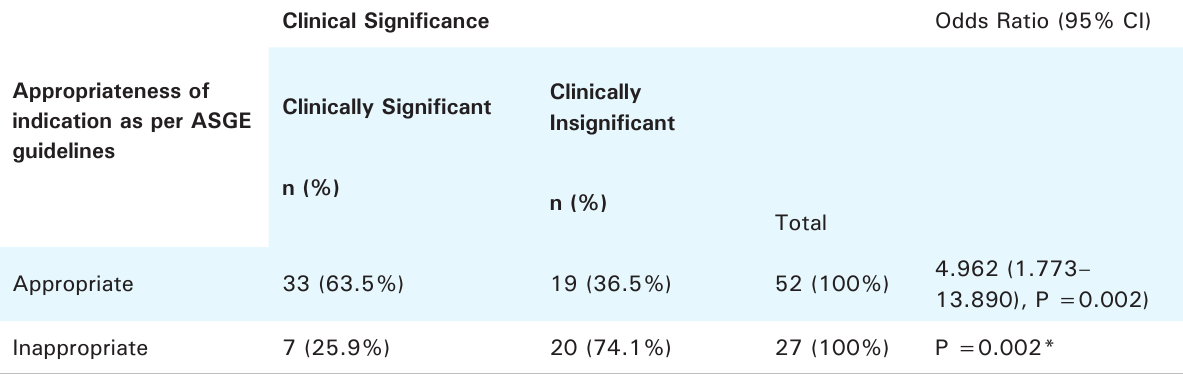
Table 4. Clinical Significant diagnosis according to appropriateness of